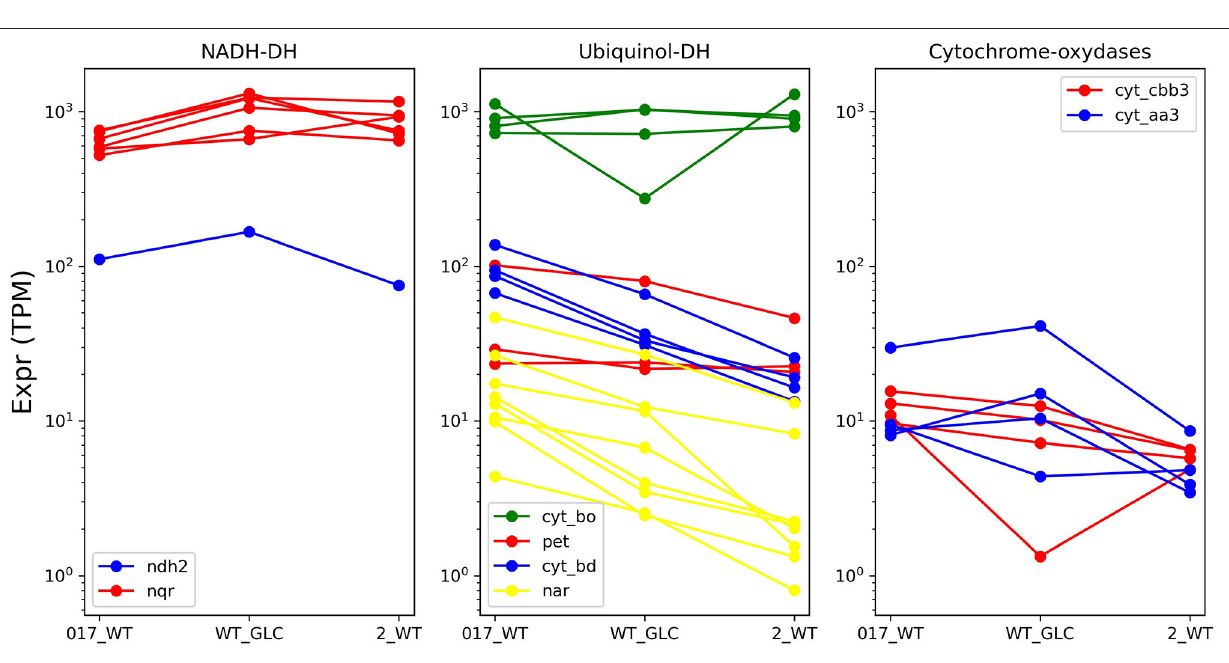
FIGURE 7 | Transcription levels of the different branches of the electron transport chain at different